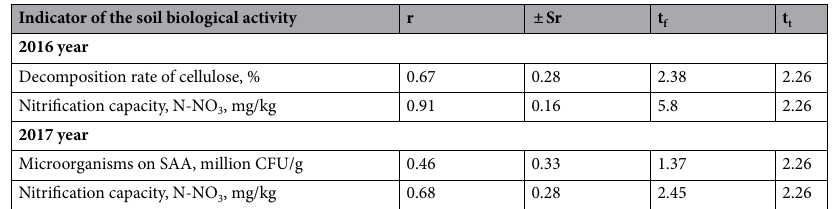
Table 4. Coefficients of correlation between various indicators of soil biological activity and crop yield, with n = 9, r crit. = 0.404. r—correlation coefficient, ± Sr—standard error of the correlation coefficient, t f , t t —criterion of the significance of the correlation coefficient (actual,